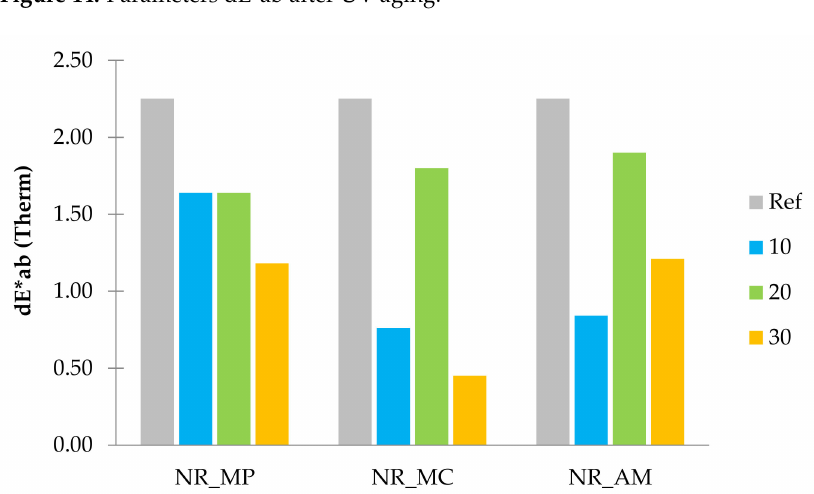
Figure 15. Parameters dE*ab after thermo-oxidative